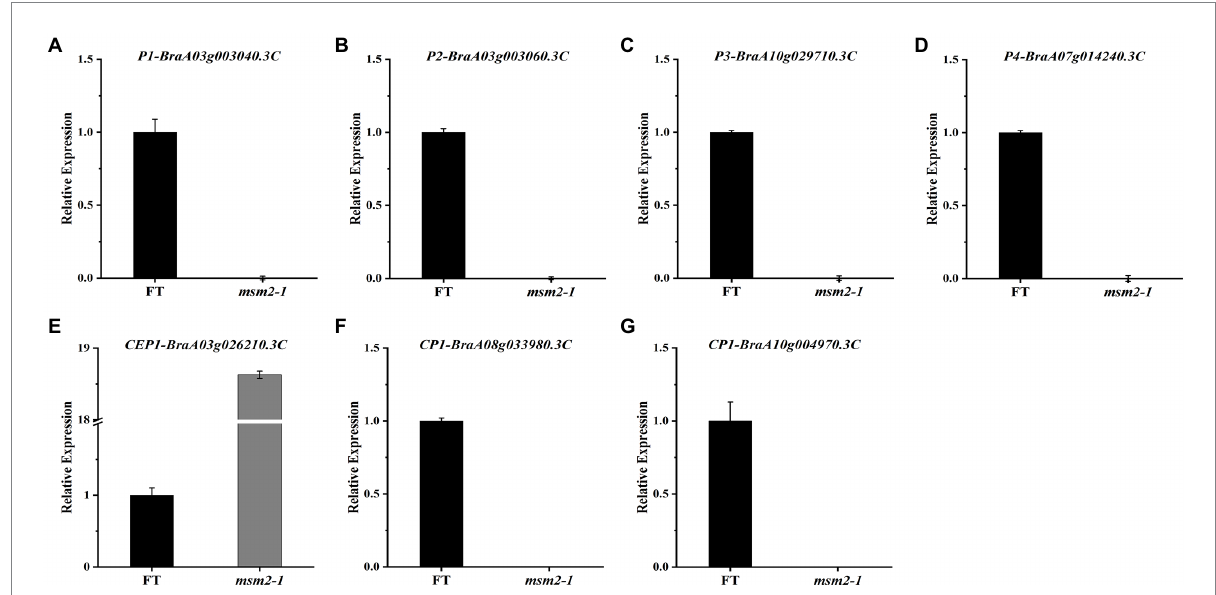
FIGURE 11 The quantitative reverse transcription polymerase chain reaction analysis of DEGs between the wild-type “FT” and msm2-1 mutant. (A–D) The expression level of pollen coat proteins in anthers between the wild-type “FT” and msm2-1 mutant. (E–G) The expression level of papain-like cysteine proteins in anthers between the wild-type “FT” and msm2-1